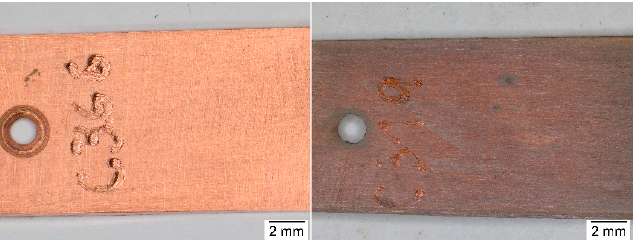
Figure 4. Total color difference of copper corrosion coupons after 1–30 months of exposure.